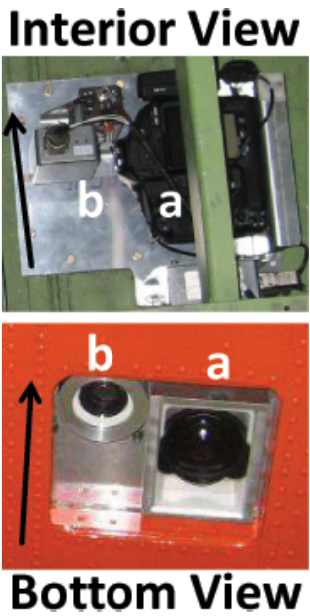
Fig. 1. Photographs of the installation of the CANON camera on board of Polar 5 (arrows indicate the flight direction). In both pho- tographs (interior and bottom view) the CANON camera is labeled with (a) and the digital video camera with (b)